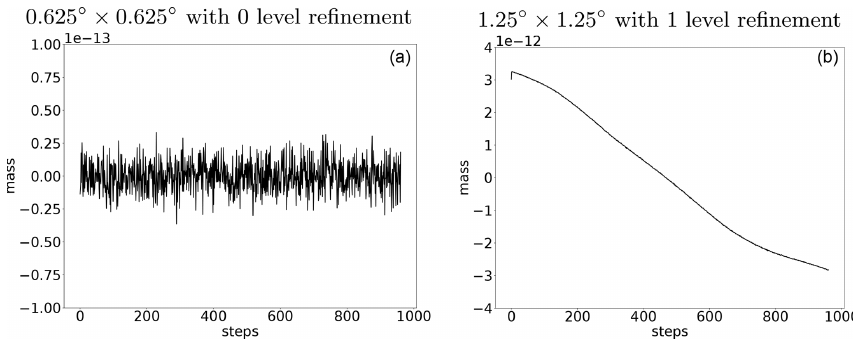
Figure 16. Evolution of mass change on both non-adaptive (a) and adaptive (b) meshes. Note that we do not plot the mass error but the mass with respect to the average, which explains the initially non-zero value for the adaptive run. The loss of mass arises from the accumulated floating point rounding error with time on adaptive meshes. The mass variation in each time step is at machine precision (on the order of 10 − 16 ).